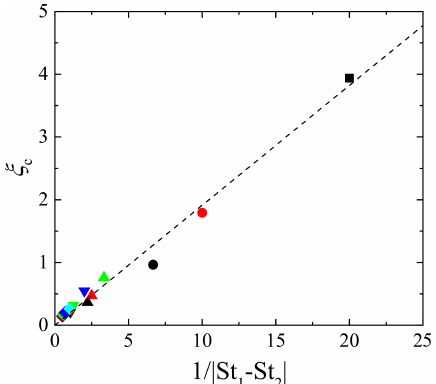
Figure 6. Critical wave number ξ c against the inverse of Stokes number difference. The dashed line is the best-fitting curve to the ξ c data. Other notations are as in Fig.